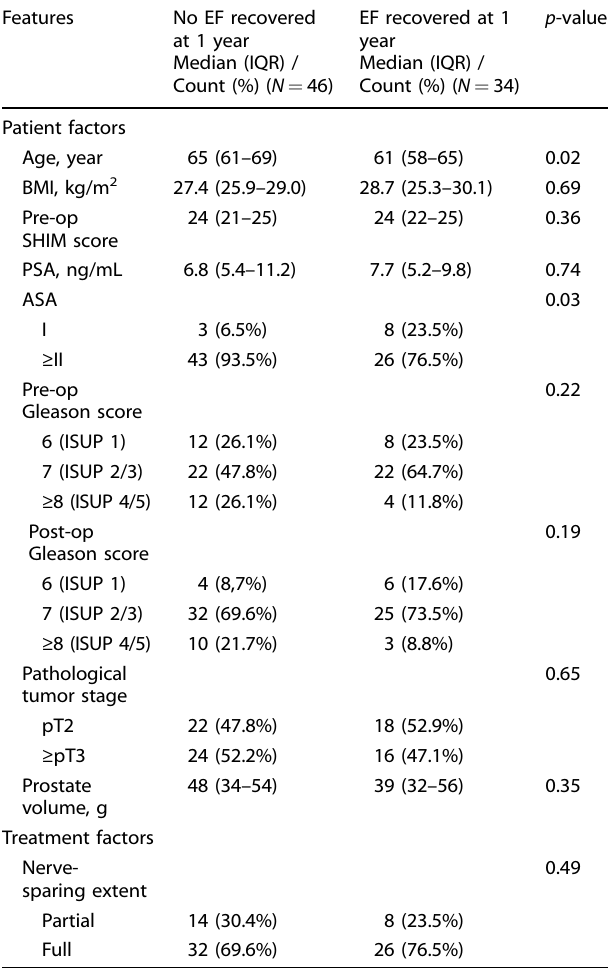
Table 1. Comparison of clinical features between the EF recovery group and the no EF recovery group at 1 year after RARP.